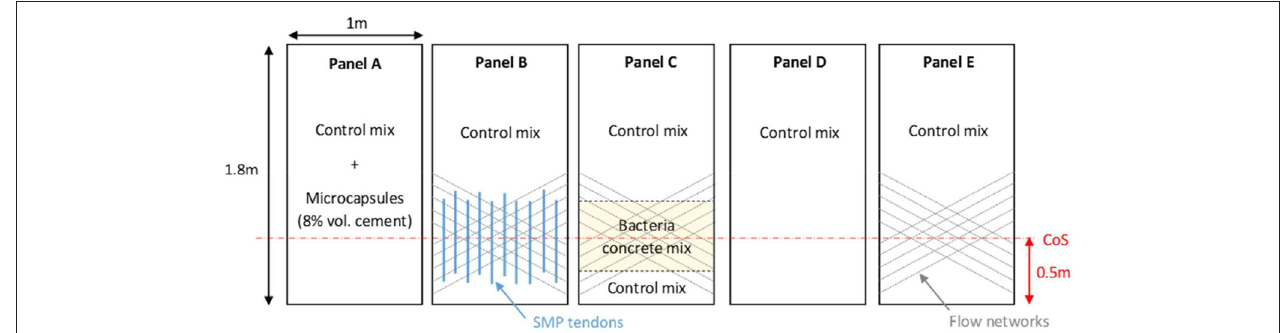
FIGURE 2 | Self-healing panel arrangement.